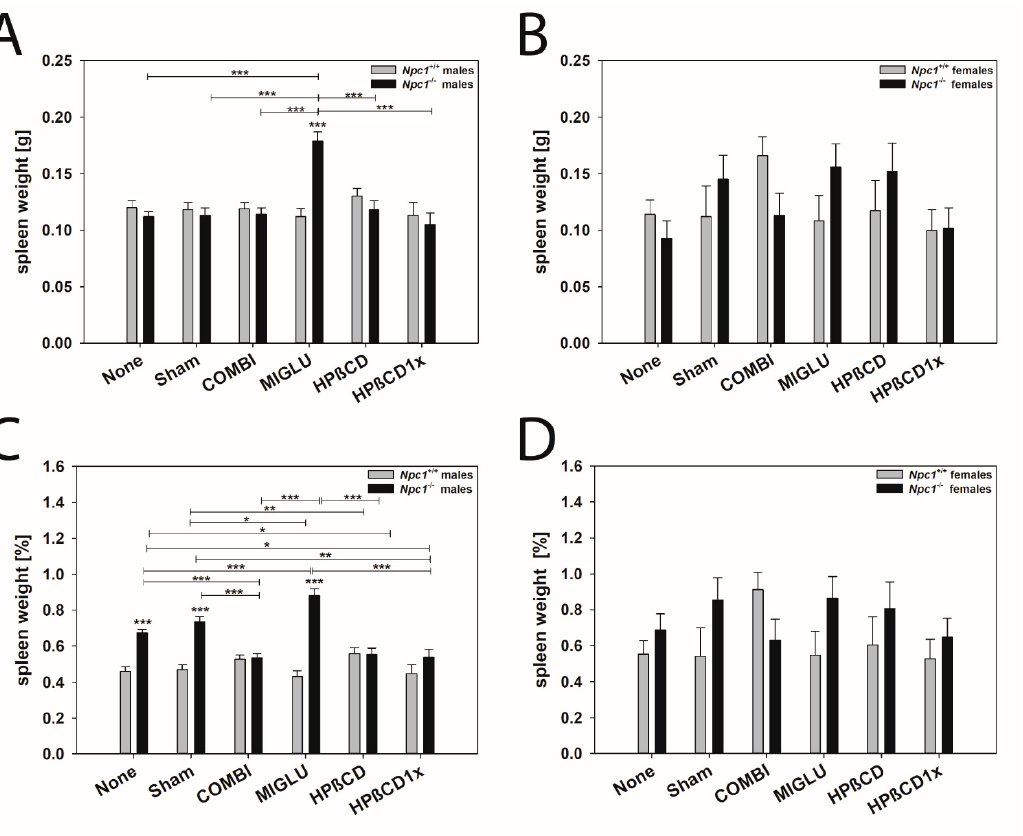
Figure 5. Spleen weight ( A , B ) and relative spleen weight ( C , D ) of Npc1 mice. Male ( A , C ) and female ( B , D ) mice. Significant post-hoc tests are indicated by asterisks (* p < 0.05, ** p < 0.01, *** p < 0.001). Data are means ± SEM.